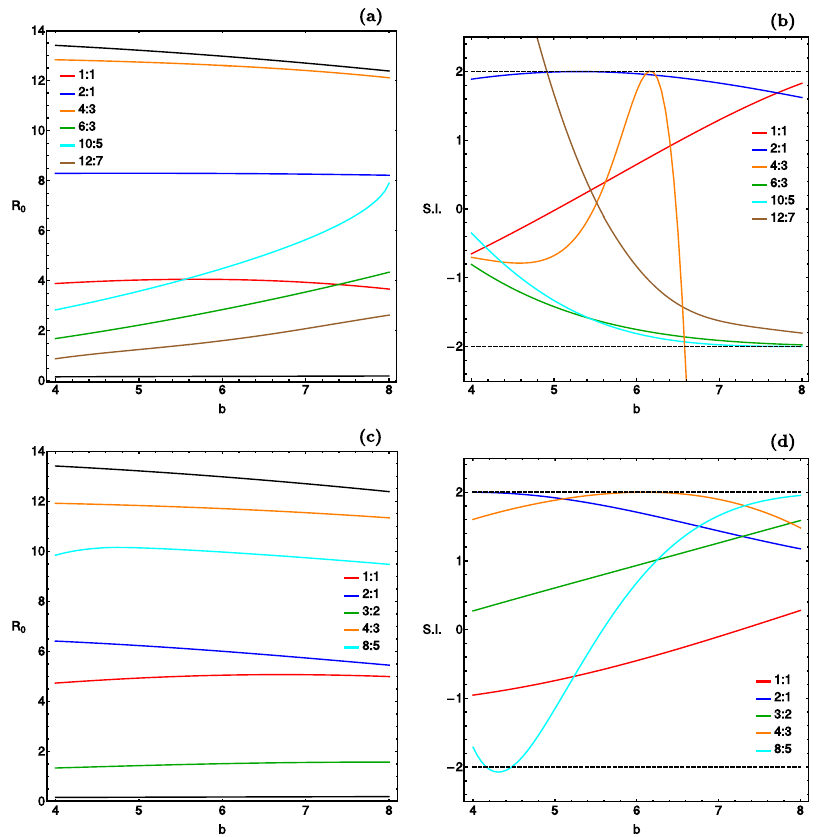
Fig. 4. Evolution of the R coordinate of periodic orbits as a function of the core radius of the disk-halo, b , for the PH models (panel a) and OH models (panel c), and the evolution of the stability index S.I. as a function of b for the PH models (panel b) and OH models (panel d). lower boundary of the family and specifically for 4 : 21 ≤ b ≤ 4 :